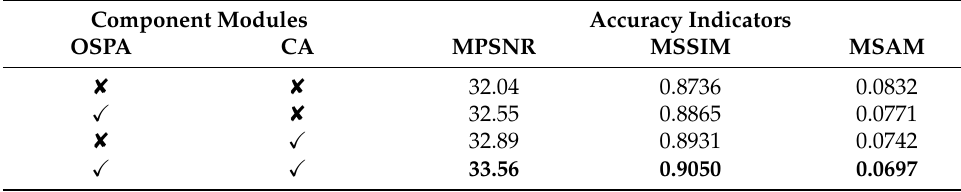
Table 7. Results of the ablation study on the effect of OSPA and CA modules.